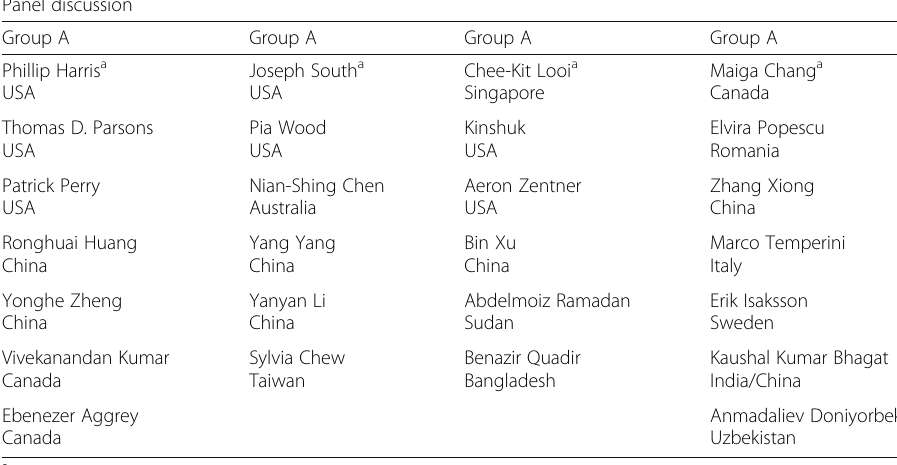
Table 1 Summit Meeting Groups Panel